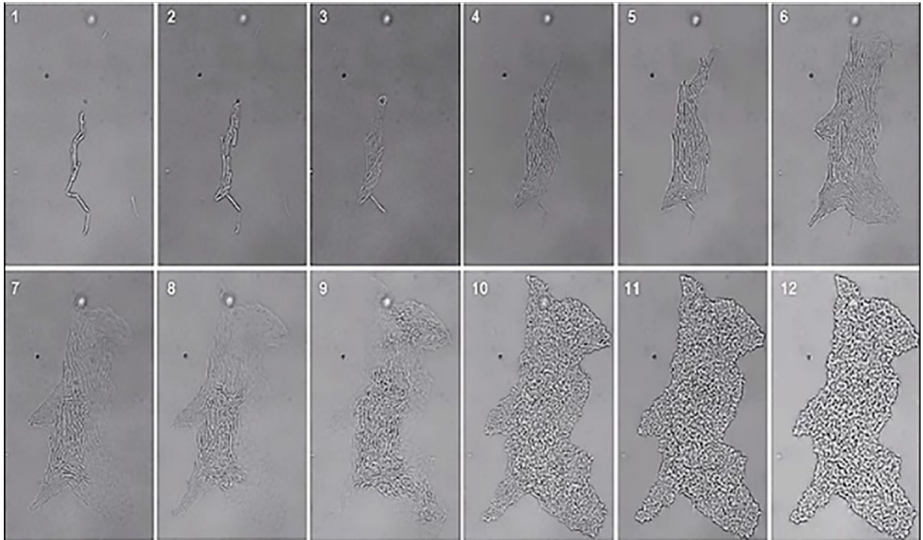
Figure 1. B. amyloliquefaciens strain MBI600 (the active ingredient of Serifel, BASF SE) spontaneously forms biofilms. Based on a previously described method [43], MBI600 single cells were observed in LB agar medium using a Leica SP8 time-lapse confocal microscope, over a 9 h